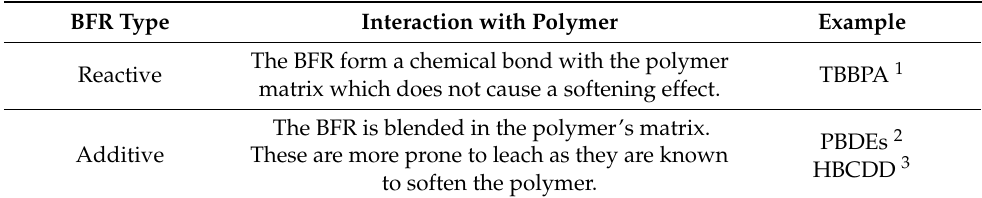
Table 1. BFR classification. BFR Type Interaction with Polymer Example Reactive